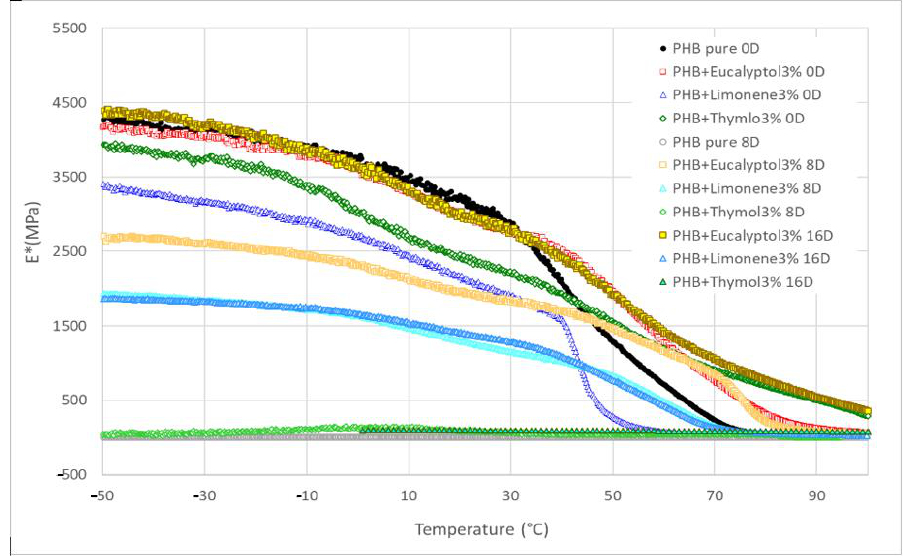
Figure 5. DMA: Complex modulus E* for PHB mixtures before and after degradation .